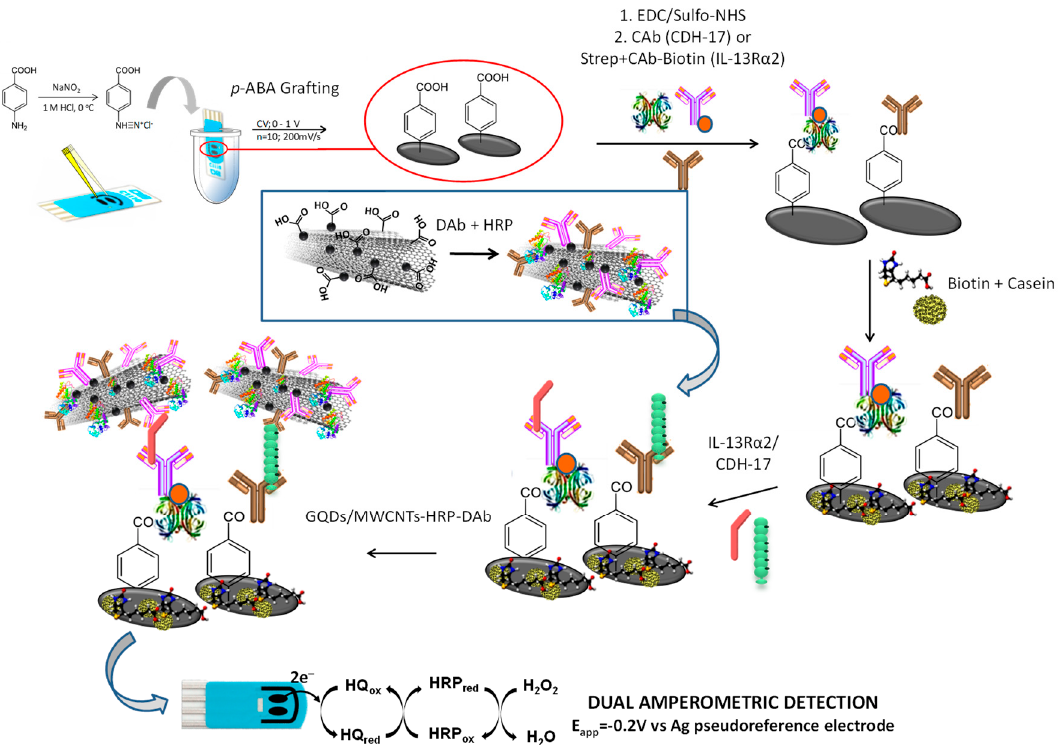
Figure 4. Steps involved in the preparation and functioning of the dual immunosensing platform developed for the amperometric determination of the target biomarkers, IL-13R α 2 and CDH-17, involving the use of MWCNTs / GQDs-HRP-DAb nanocarriers. Figure drawn by ourselves based on [48].